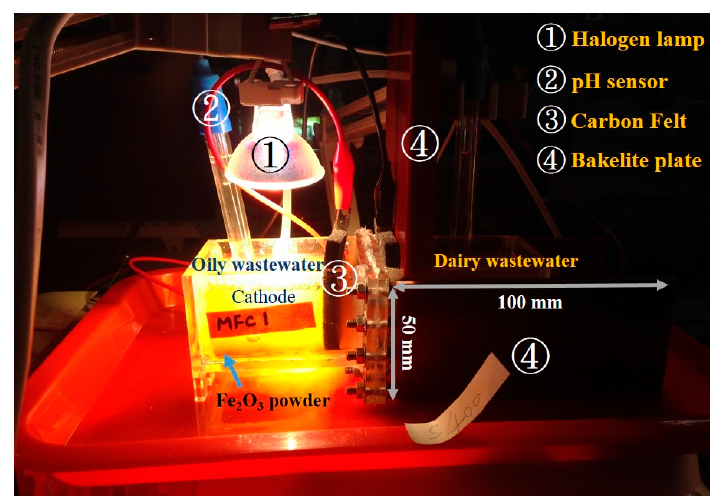
Figure 2. The experimental set-up of the proposed reactor.